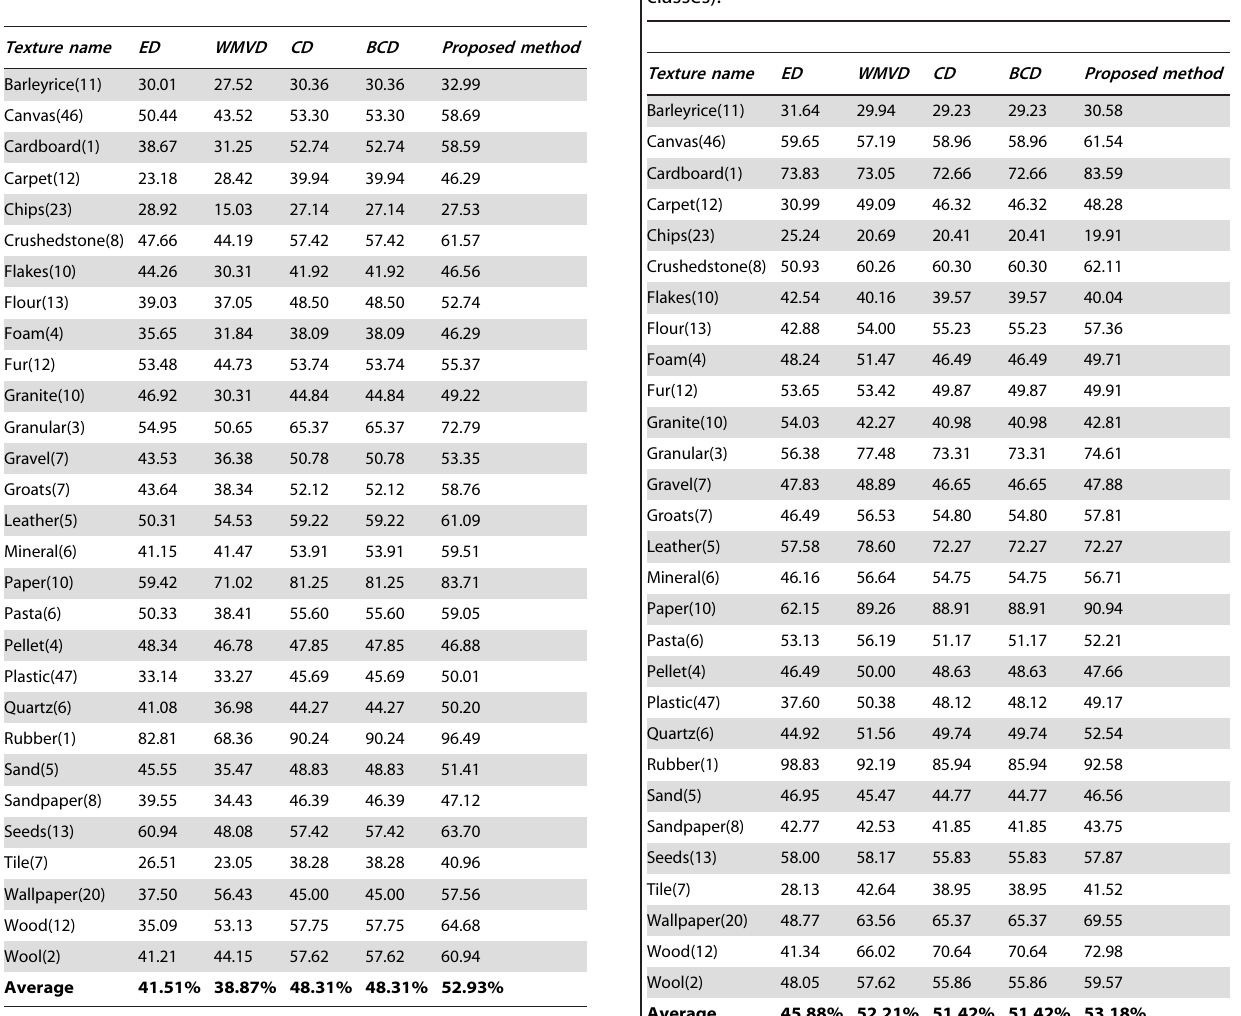
Table 5. Comparison of retrieval performance of different types of metrics for texture image retrieval using NSCT on the Outex image database (5104 images of 319 different classes).